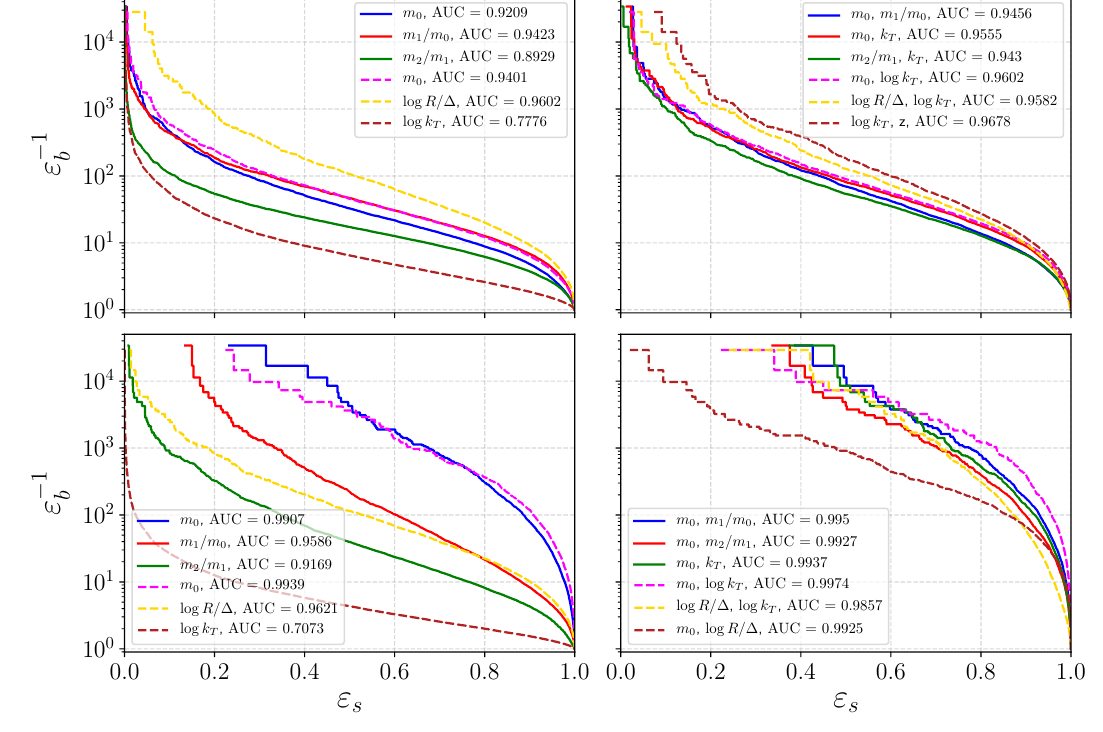
Figure 9 . Classi(cid:12)cation power of individual observables (left column) and pairs of observables (right column) for both t (cid:22) t (top row) and W 0 (bottom row) signals versus QCD. We consider both mass basis observables (solid lines), and observables in the primary Lund plane (dashed